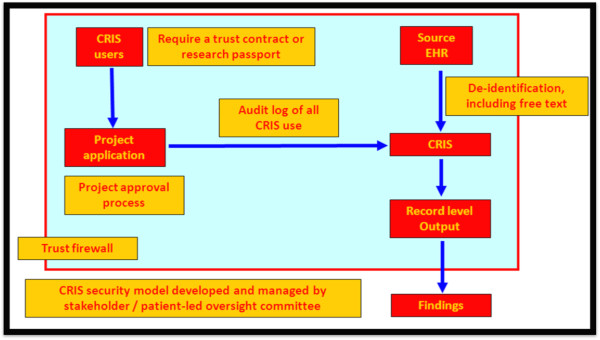
CRIS security model.